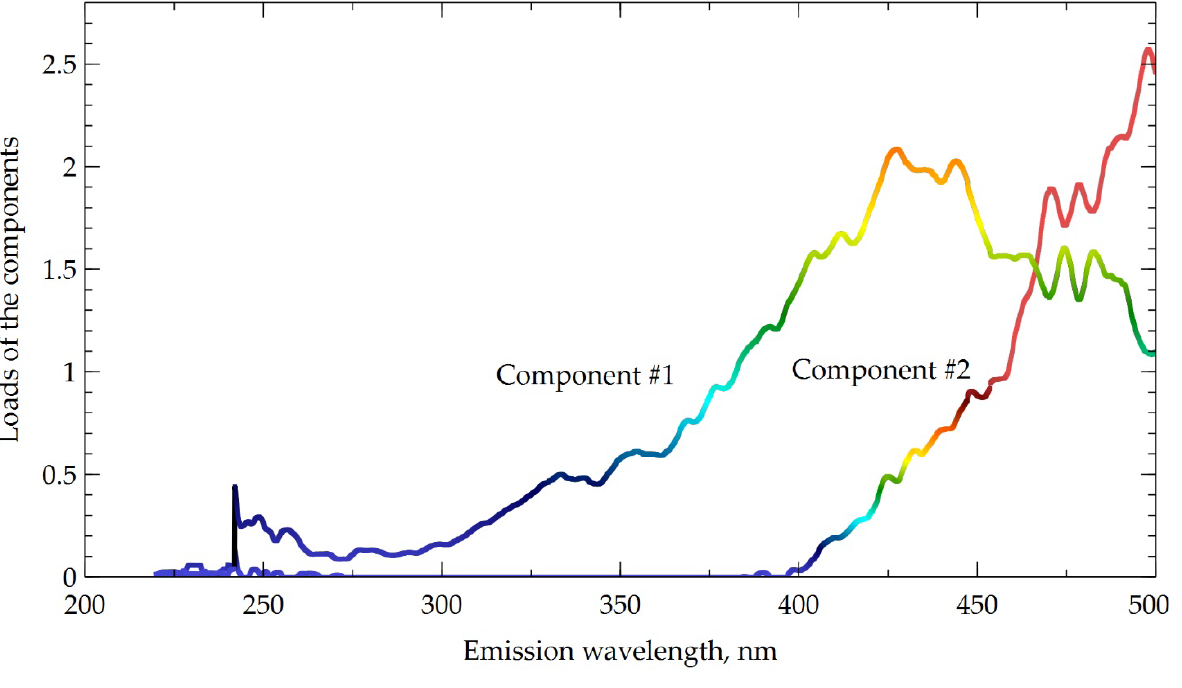
Table 6. Linear correlations between measured values and those predicted with the PARAFAC model antioxidant activity.